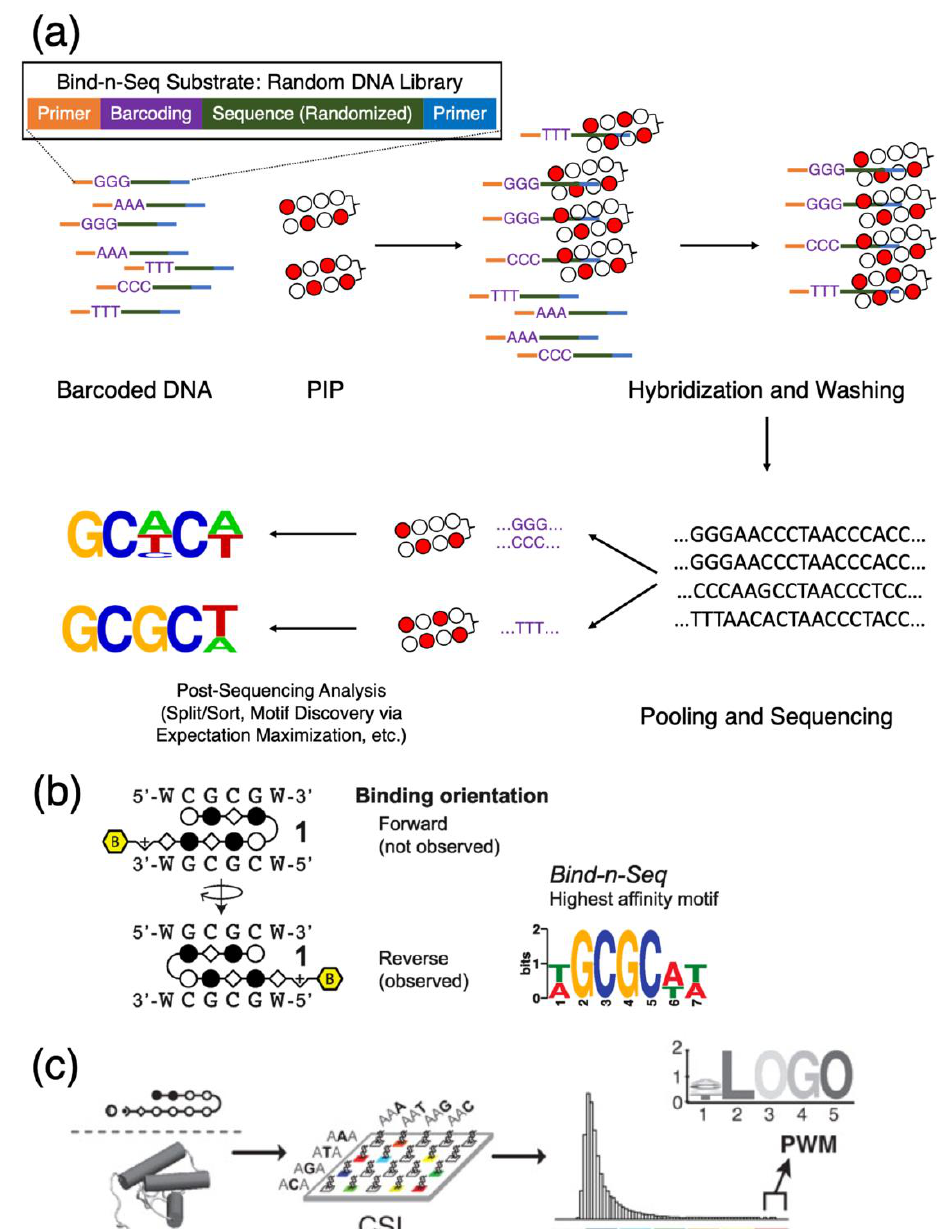
Figure 4. Mechanics of using Bind-n-Seq to elucidate the sequence specificity of PIPs. ( a ) Schematics of Bind-n-Seq, beginning with a random oligonucleotide library to create a possible sequence space for downstream analysis. ( b ) The ability to extract intricate details about PIP-binding modes with Bind-n-Seq; example shown here is the different in binding orientation. Reprinted with permission from [52], © 2014 American Chemical Society. ( c ) Cognate site identifier, or CSI, as a variation of a similar theme to identify binding motifs; motif enrichment results can then be transformed into position weight matrices (PWM) or presented as motif logo maps. Reproduced from [55], © 2010 National Academy of Sciences.